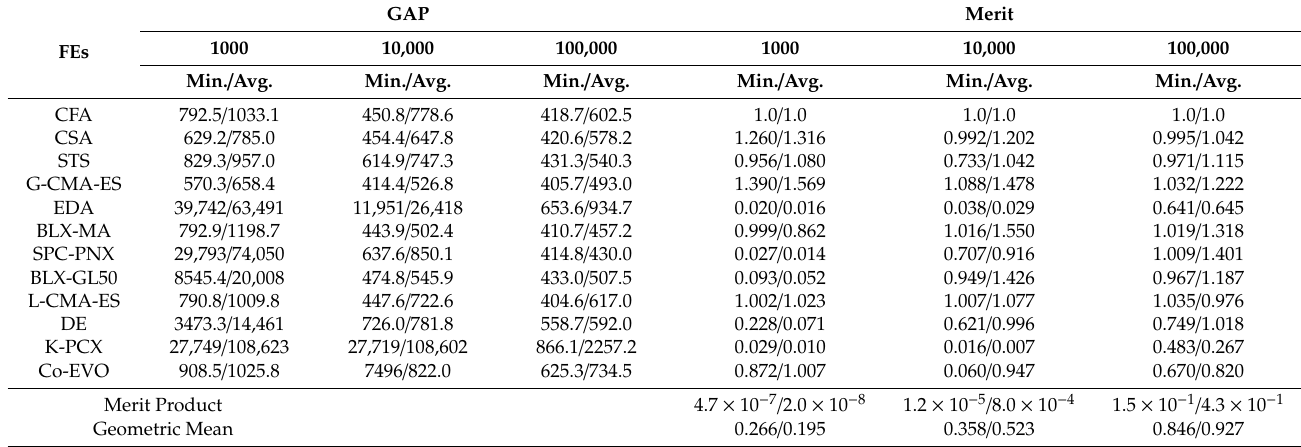
Table 11. Min. / Avg. GAP and Merit over the CEC dataset with n =